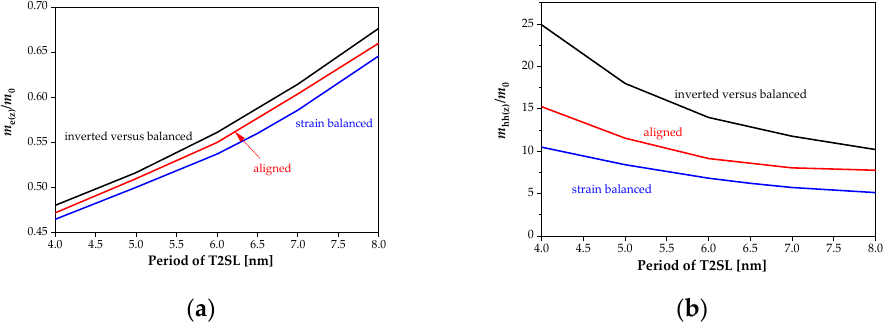
Figure 8. Theoretical simulation of the electrons’ ( a ) and holes’ ( b ) effective masses in the z direction for the strain-balanced and strained SL (the Sb molar composition for 0.22 eV T2SL bandgap energy).